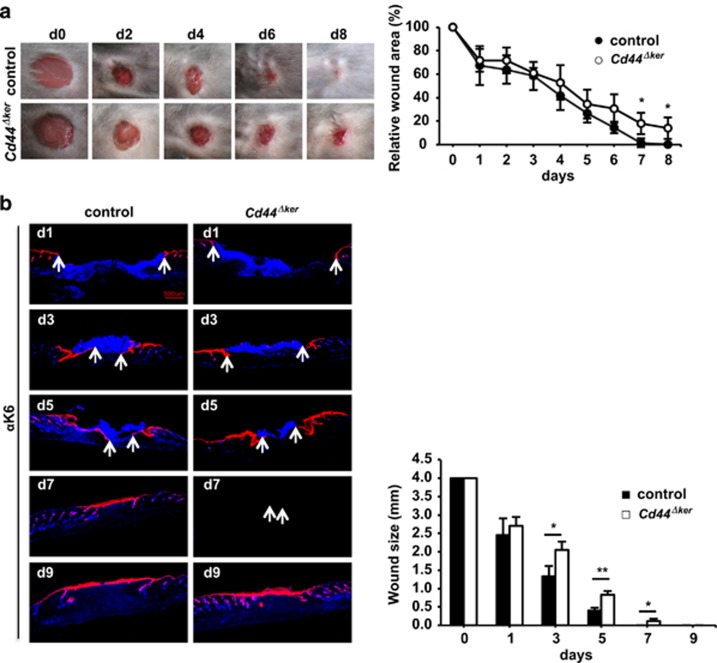
Impaired wound healing in Cd44Δker mice. (a) 4 mm full-thickness excisional dorsal skin wounds were performed on Cd44Δker and control animals and photographed at the indicated days. Wound closure was quantified by ImageJ and expressed relative to the initial wound area. (b) Wound sections were stained for keratin 6 (red) and nuclei counterstained with DAPI (blue). Images were taken by fluorescence microscopy (KEYENCY BZ-9000) using a × 2 objective. Bar=500 μm. Quantification of the distance between the keratinocyte migration fronts (white arrows). Bars represent means ±S.E.M., n=6. Student's t test: *P<0.05, **P<0.005. Experiments were performed at least three times and gave similar results